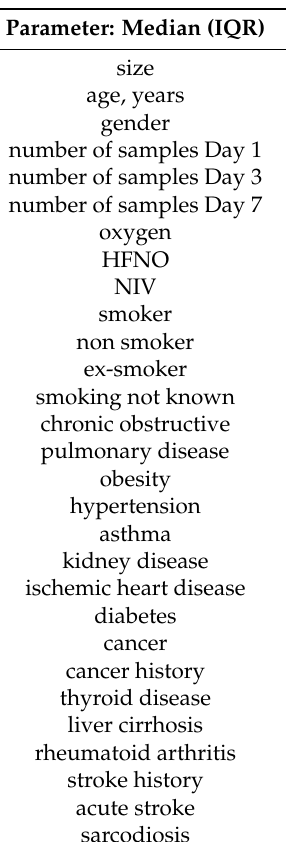
Table 1. Characteristics of patients included in the